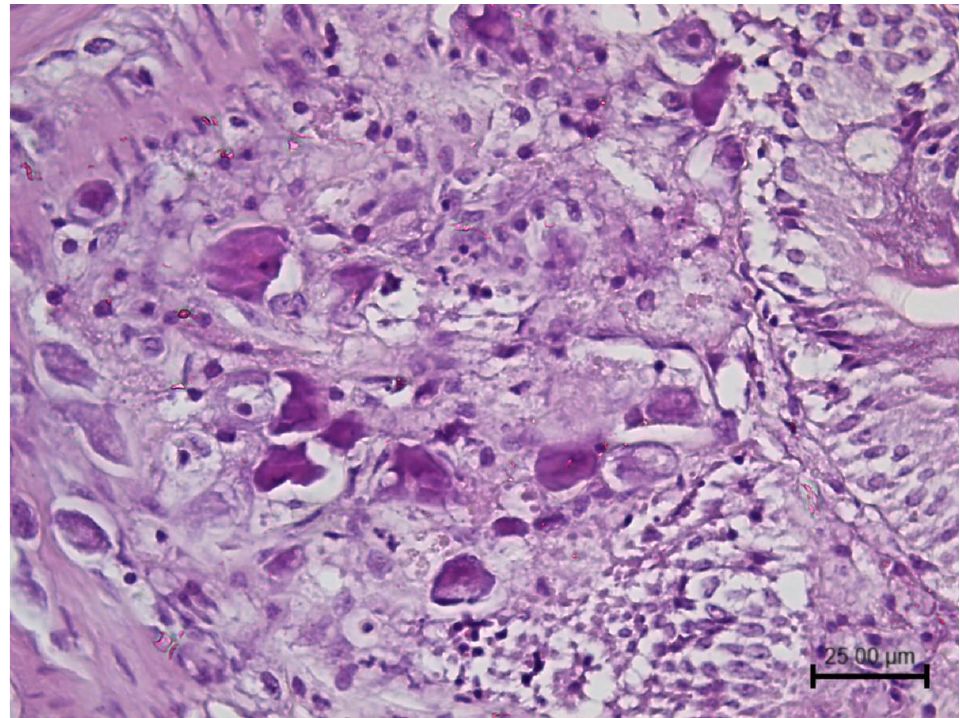
Figure 2. Histopathology of intestine from a megalocytivirus-infected prickly leather-jacket ( Chaetodermis penicilligerus ) showing multiple hypertrophic cells containing granular basophilic viral inclusions. Haematoxylin and eosin (H&E) stain. (Courtesy Prof. Gian Enrico Magi University of Camerino, Italy).